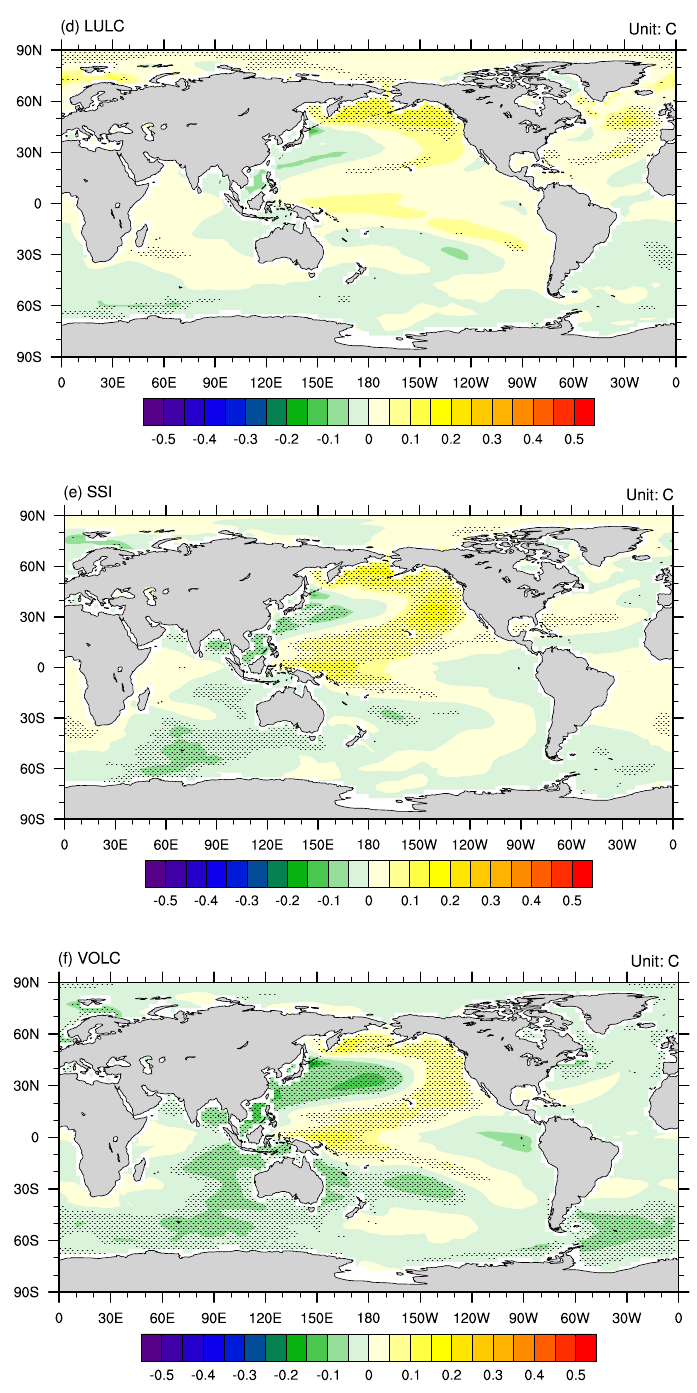
Figure 7. Simulated ensemble-averaged annual SST anomalies (unit: ◦ C) during the megadrought years from the long-term means of the control (CTRL) run ( a ), all-forcing (ALL) runs ( b ), greenhouse gas (GHG) runs ( c ), land use and land cover (LULC) runs ( d ), spectral solar irradiance (SSI) runs ( e ), and volcanic eruption (VOLC) runs ( f ). Stippling indicates differences significant at the p = 0.05 level based on a t -test.